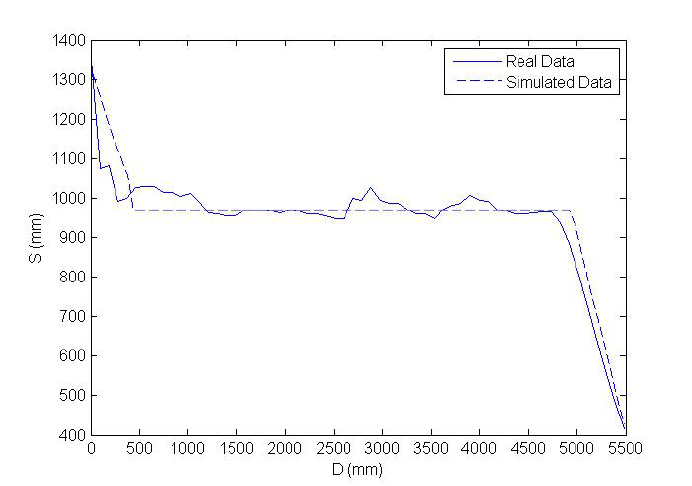
Figure 10. Distances measured by one of the sonar systems vs . vehicle position. The Average of distances has been used for the real sonar data and the raw distances has been used for the data extracted from the simulated